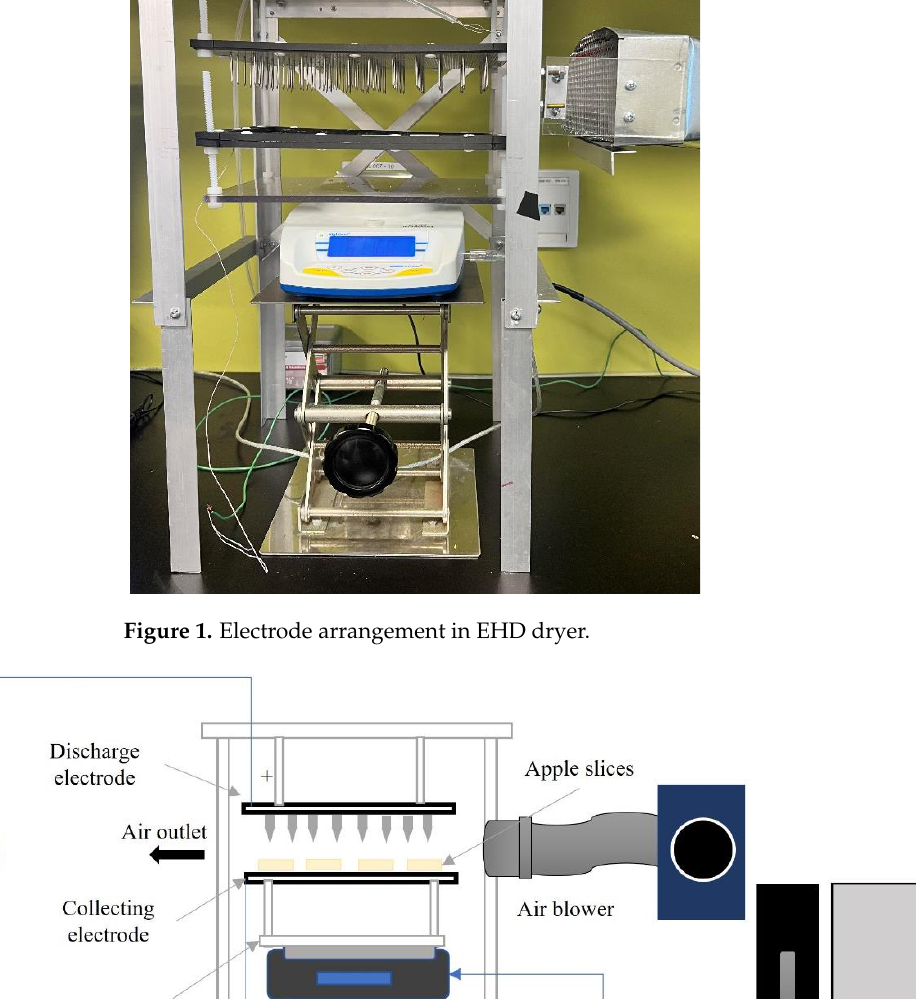
Figure 1. Electrode arrangement in EHD dryer.